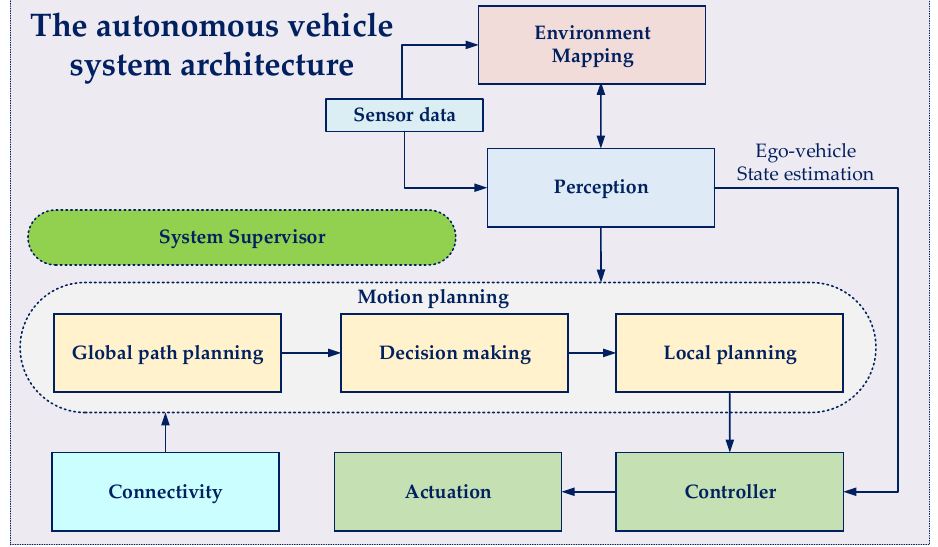
Figure 1. A general framework of an autonomous driving system which is composed of the perception and environment mapping, motion planning, and